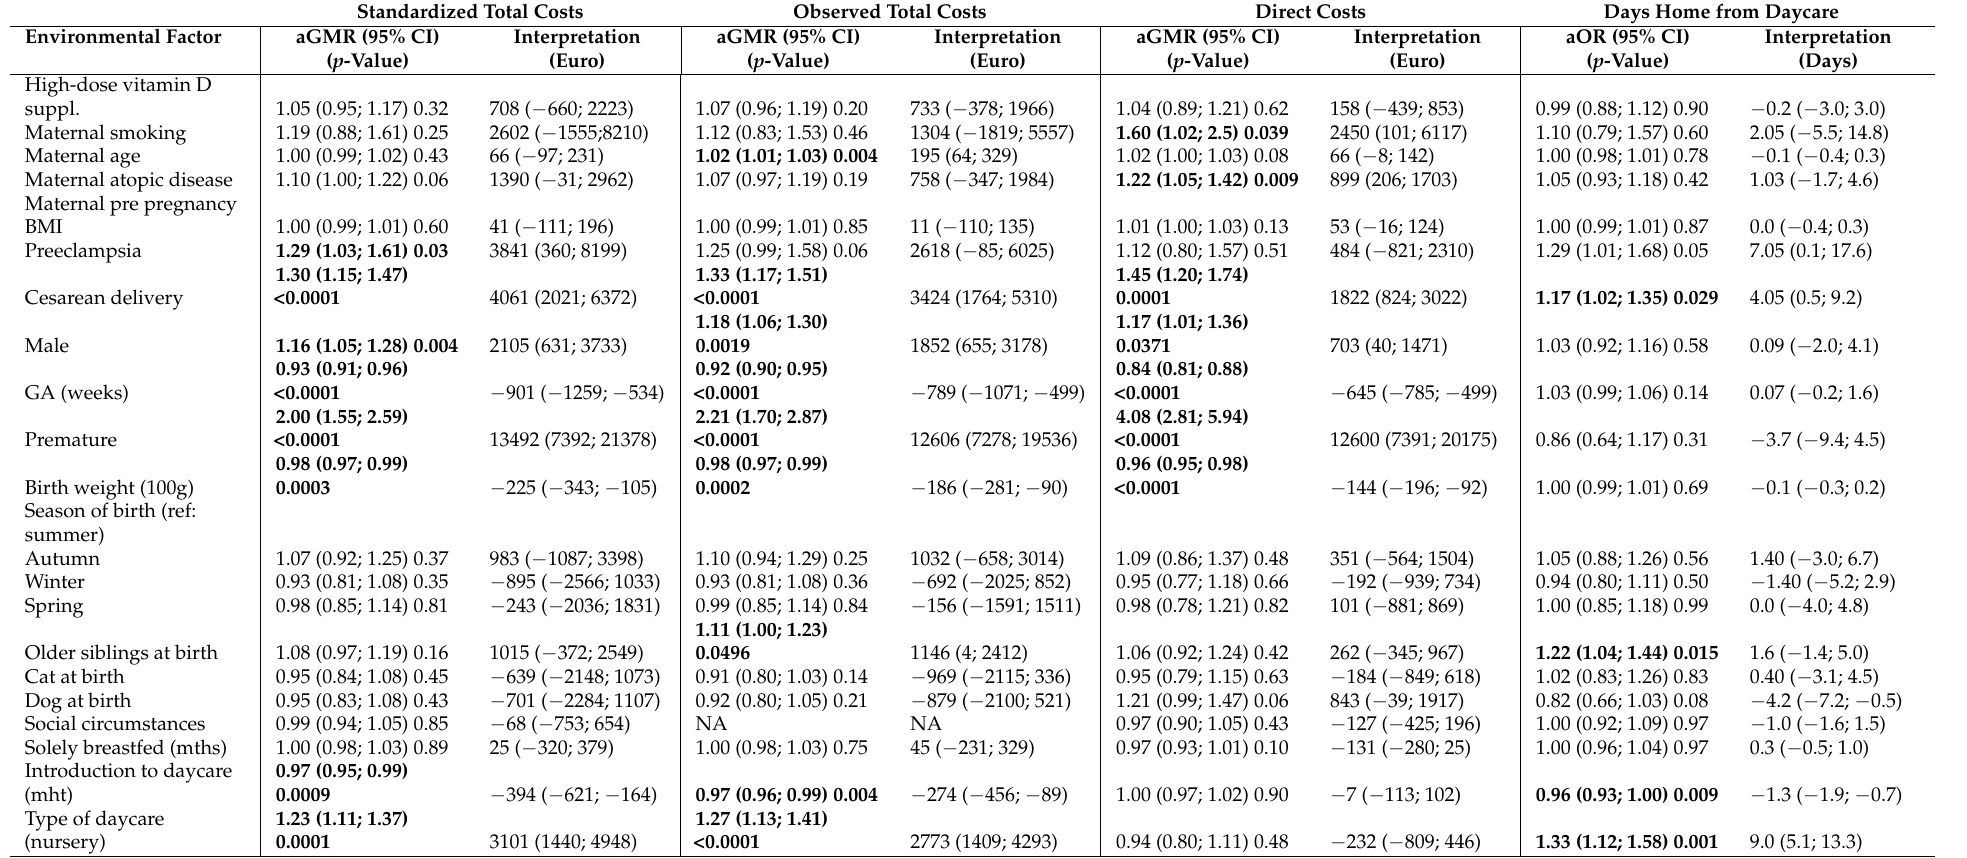
Table 2. Associations between environmental factors, costs and days absent from daycare during the first three years of life (adjusted for fish-oil supplementation). Significant associations in